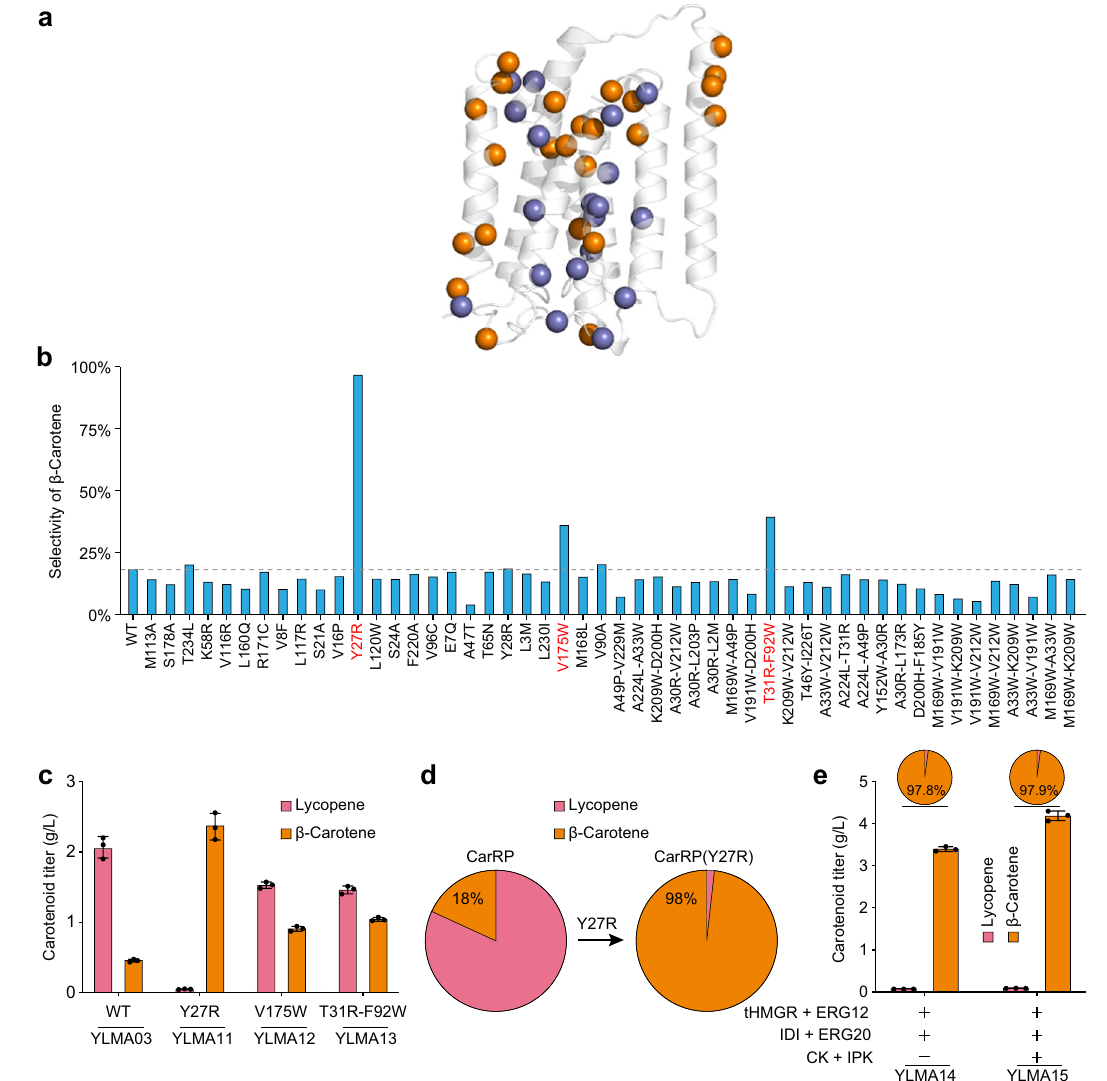
Fig. 2 Abolishment of substrate inhibition through protein engineering. a Using a predicted protein model, several positions within the R domain (lycopene cyclase) of CarRP were identi fi ed as suitable locations for mutation in order to reduce substrate inhibition. Single substitutions are indicated by copper spheres whereas double substitutions are indicated by purple spheres. b β -carotene selectivity was tested on a total of 50 generated variants. Compared to wild type (WT), Y27R, V175W, and T31R-F92W (in red) showed the signi fi cantly increased β -carotene selectivity, suggesting a reduction in substrate inhibition. Data represent the mean value of two independent experiments. c , d Compared to the control strain YLMA03 harboring wild-type CarRP, the variants showed signi fi cantly increased production of β -carotene, along with a decrease in lycopene accumulation ( c ). In particular, the strain YLMA11 expressing CarRP (Y27R) achieved a titer of 2.38 g/L ( c ), in addition to a high selectivity of 98% ( d ). e The abolishment of substrate inhibition allowed higher fl uxes to be channeled through the carotenoid synthesis pathway (through MVA and IUP overexpression), improving β -carotene titers while maintaining the high selectivity. Ultimately, 4.22 g/L β -carotene was produced in YLMA15 with ~98% selectivity. For cultures using strains containing IUP, 30 mM isoprenol (Supplementary Fig. 10) was added to the media post-glucose depletion. For c to e , the average and s.d. of three biologically independent experiments are shown. Source data are provided as a Source Data fi